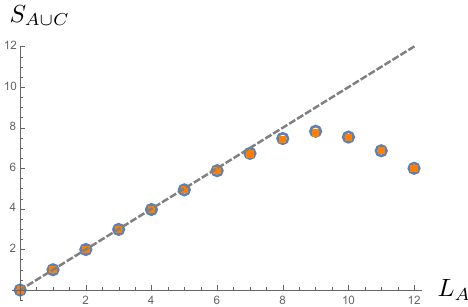
Figure 2: The von Neumman entropy (using log ) for a subsystem A ∪ C in the TMD 2 + L ) spins for a chaotic spin chain (blue circles) and state for a random subset of ( L A C integrable spin chain (orange squares). The dashed line is the thermal entropy. The total number of spins on each side in both models is L = 6, and we take β = 0 for simplicity. Each data point is obtained from averaging over all possible configurations of A and C . The size of markers does not represent error bars; there is very small variance between individual realizations. The entropy is clearly extensive regardless + L ≤ L . Moreover, it is not sensitive to the integrability of the of partitioning for L A C